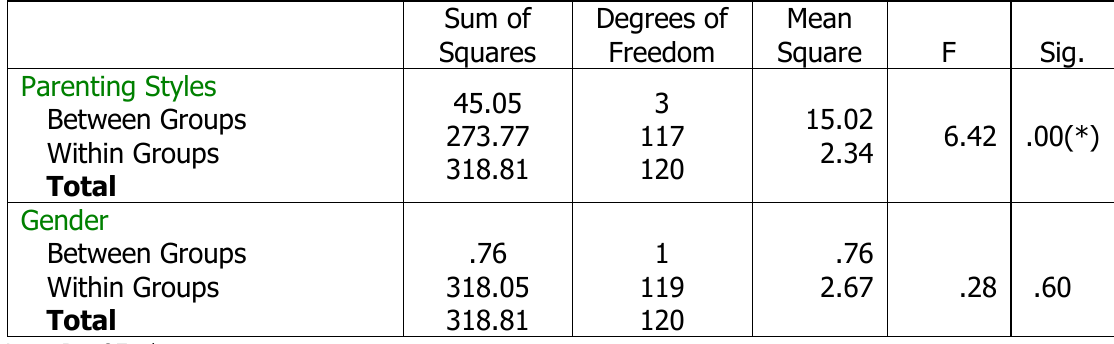
Post-hoc evaluation of significant differences of mean age of sexual debut between parenting styles.